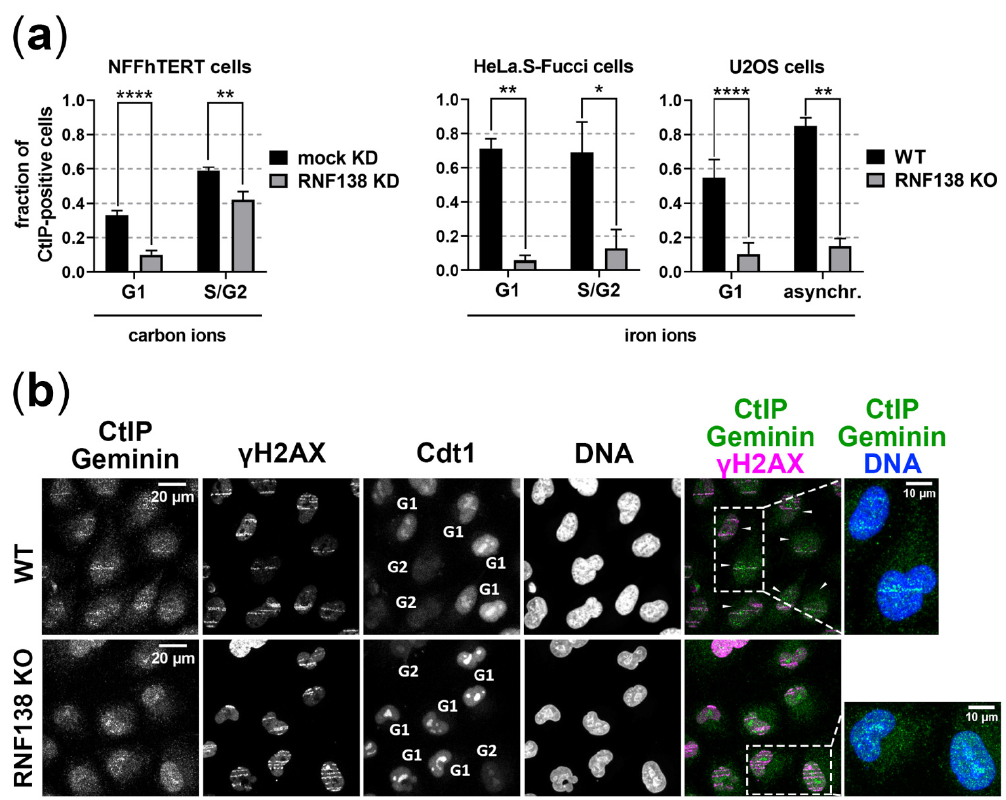
Figure 4. RNF138 is required for the recruitment of CtIP to DSBs in G1-phase cells. NFFhTERT, HeLa.S-Fucci, or U2OS cells, the latter ectopically expressing CtIP-mCherry, RNF138 proficient or deficient [mock KD and RNF138 KD (see Supplementary Figure S3) or wt and RNF138 KO, respectively] were irradiated in a low angle (5 × 10 6 p./cm 2 ) with carbon ions (6.5 MeV/nucleon) or low-energy iron ions and fixed 1 h after irradiation. The samples were immunofluorescence-stained for CtIP and the cell-cycle marker Geminin (Geminin positive: S and G2 cells, Geminin negative: G1 cells; NFFhTERT and U2OS only) or for CtIP and the DSB marker γ H2AX (HeLa.S-Fucci cells). DNA was counterstained with DAPI to visualize the nuclei of all cells. Cells positive for CtIP-decorated ion traversals (streak-like pattern) within their nuclei were considered CtIP positive. ( a ) At least 100 cells per condition were analyzed from at least 6 fields of view in order to average the number of CtIP-positive cells. n = 1, error = SEM. Two-tailed Mann-Whitney test, p values: * p < 0.05; ** p < 0.01; **** p < 0.0001. ( b ) Representative image of CtIP signal in WT and RNF138 KO HeLa.S-Fucci cells. The CtIP signal is overlaid by the signal of mAG-tagged Geminin, a part of the Fucci system. mKO2- tagged Cdt1 of the Fucci system served as cell-cycle marker. White arrows indicate CtIP-positive cells. An enlarged version of the areas highlighted by dashed boxes is shown to the